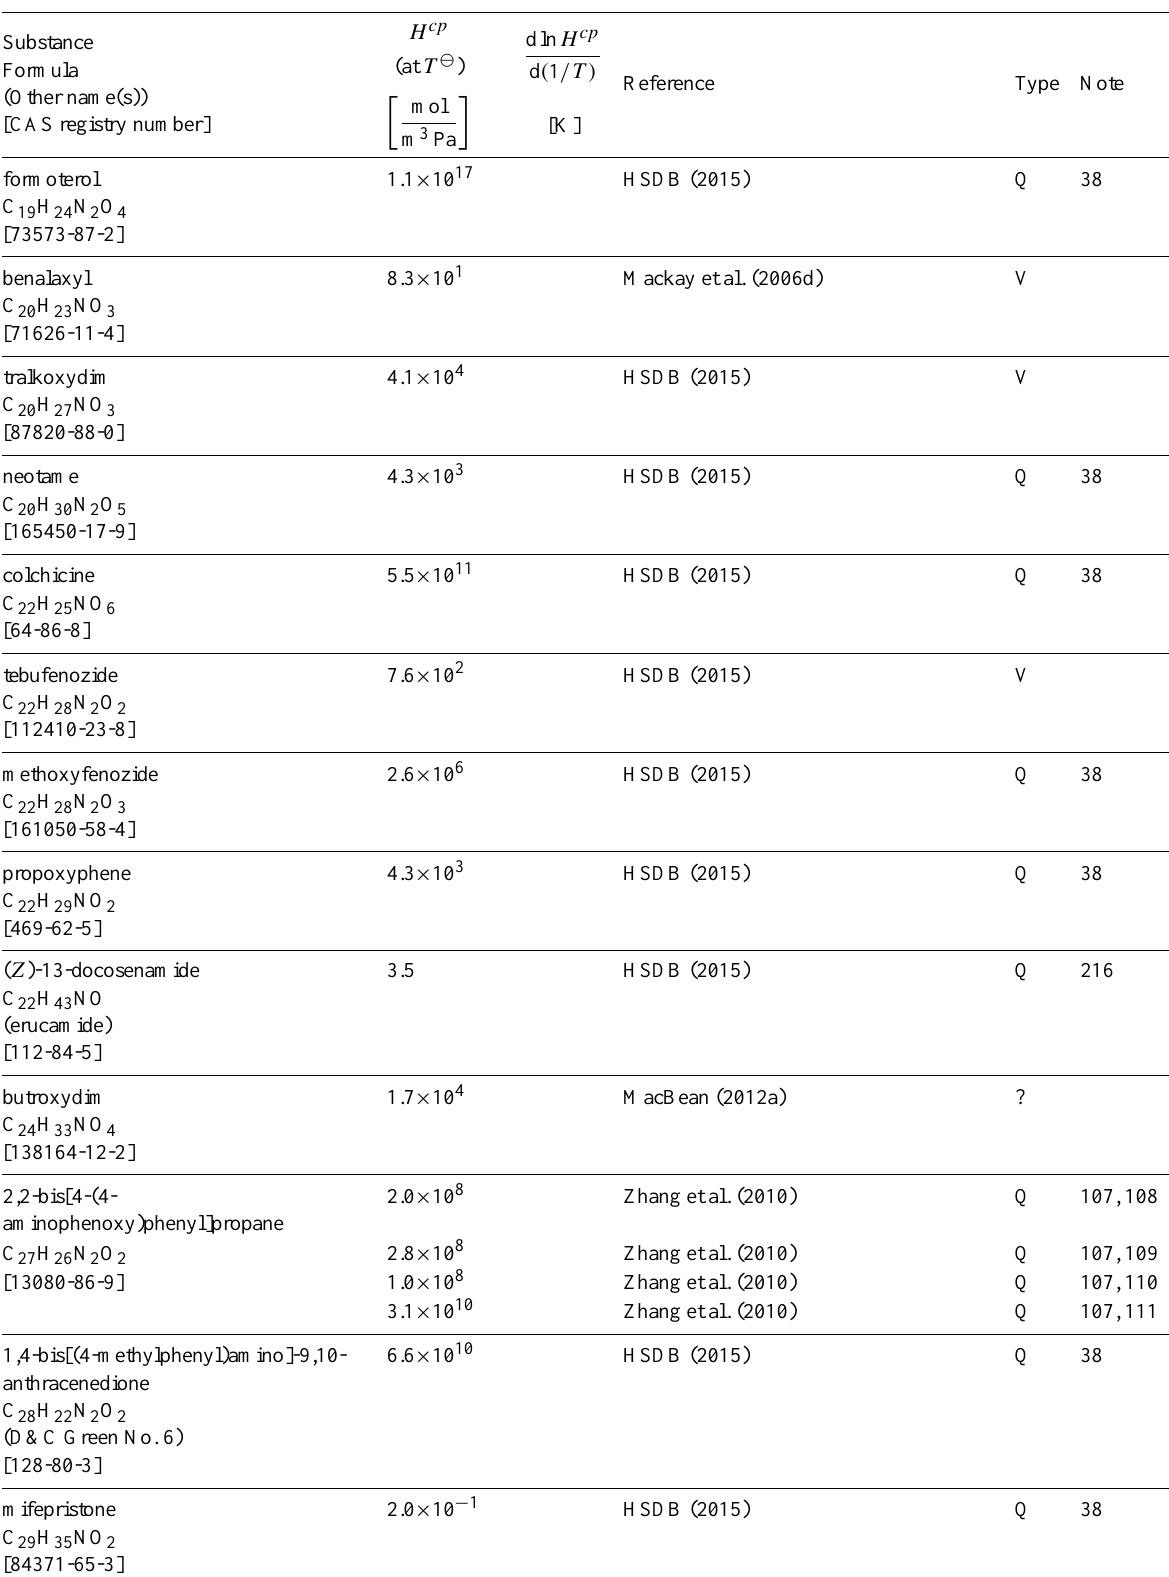
Table 6: Henry’s law constants for water as solvent